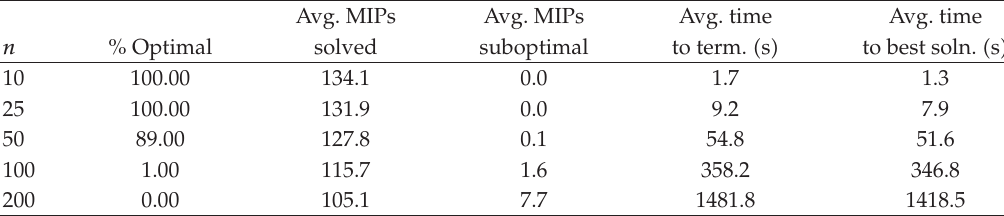
Table 7: Computational performance of L 1 OR implementation for consistency experiment.